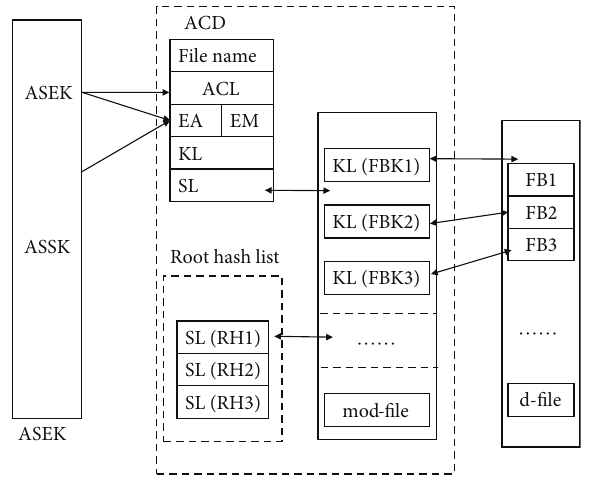
Figure 1: HMSS data logical structure and key management.